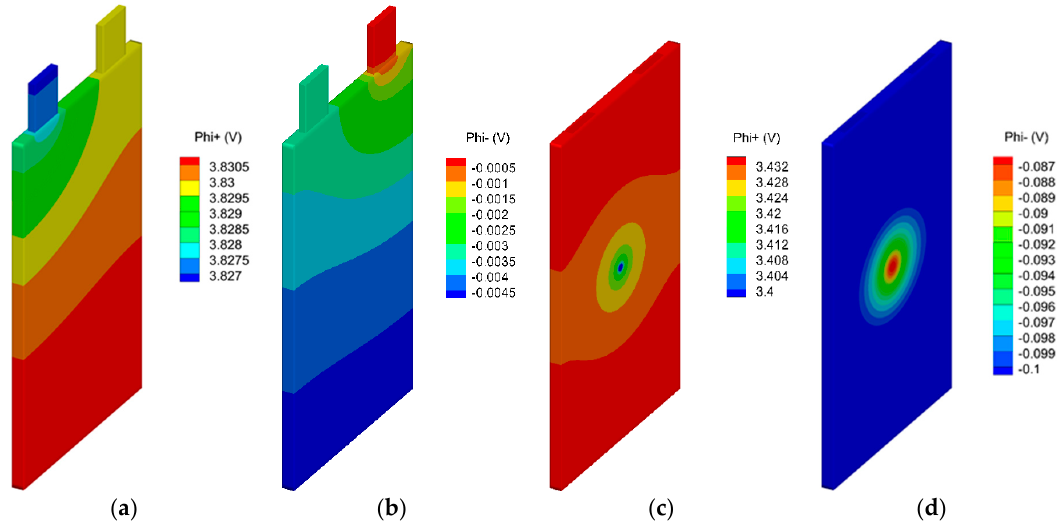
Figure 4. Distributions of ( a ) Φ + under 1C discharging; ( b ) Φ − under 1C discharging; ( c ) Φ + under Figure 4. Distributions of ( a ) 𝛷 (cid:2878) under 1C discharging; ( b ) 𝛷 (cid:2879) under 1C discharging; ( c ) 𝛷 (cid:2878) under internal shorting by 0.01 Ω ; ( d ) 𝛷 (cid:2879) under internal shorting by 0.01 Ω . internal shorting by 0.01 Ω ; ( d ) Φ − under internal shorting by 0.01 Ω Figure 4. Distributions of ( a ) 𝛷 (cid:2878) under 1C discharging; ( b ) 𝛷 (cid:2879) under 1C discharging; ( c ) 𝛷 (cid:2878) under internal shorting by 0.01 Ω ; ( d ) 𝛷 (cid:2879) under internal shorting by 0.01 Ω .